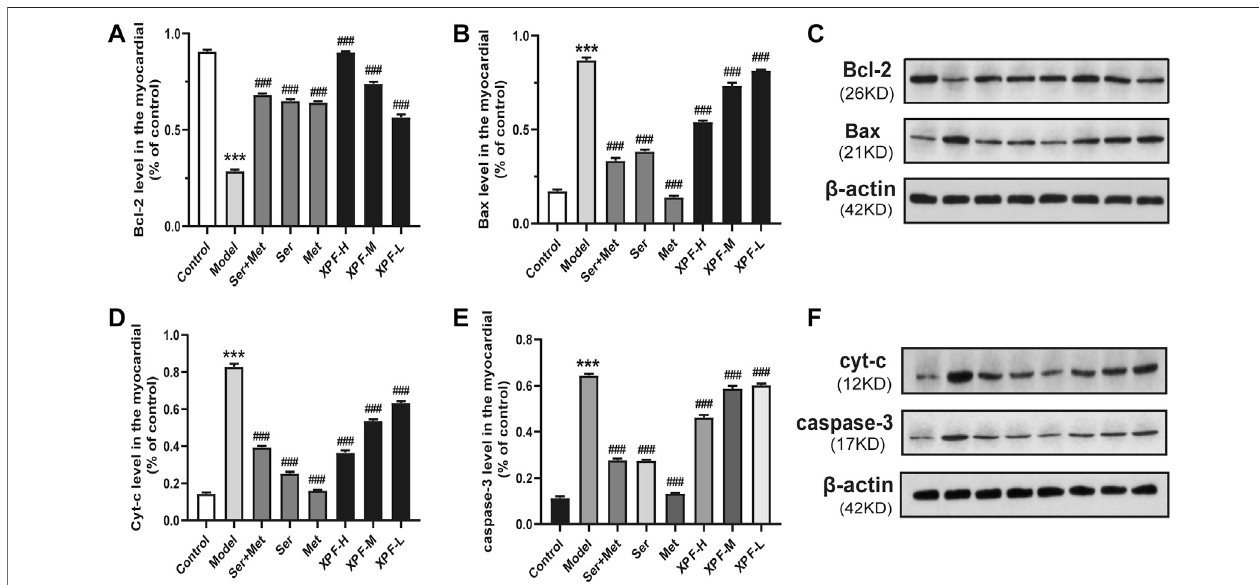
FIGURE 8 | Experimental validation of key targets Bcl-2, BAX, Cyt-c, caspase-3 in rat myocardium induced by CUMS and ISO. (A) Quantitative analysis of Bcl-2 expression in themyocardial. (B) Quantitative analysis ofBAX expression in themyocardial. (C) Western blot analysisof Bcl-2 and BAX protein. (D) Quantitativeanalysis ofCyt-cexpressioninthemyocardial. (E) Quantitativeanalysisofcaspase-3expressioninthemyocardial. (F) WesternblotanalysisofCyt-candcaspase-3protein.Data were presented as means ± SD ( n (cid:2) 3). *** p < 0.005 compared with the control group, ### p < 0.005 compared with the model group.